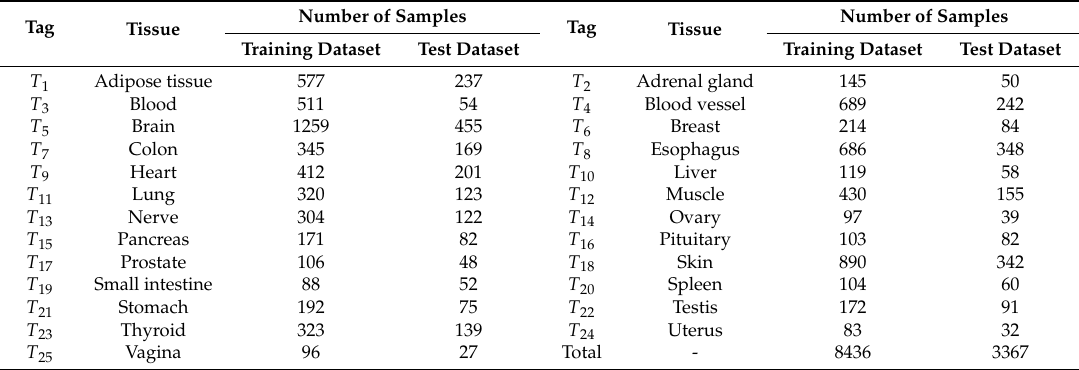
Table 1. The 25 tissue